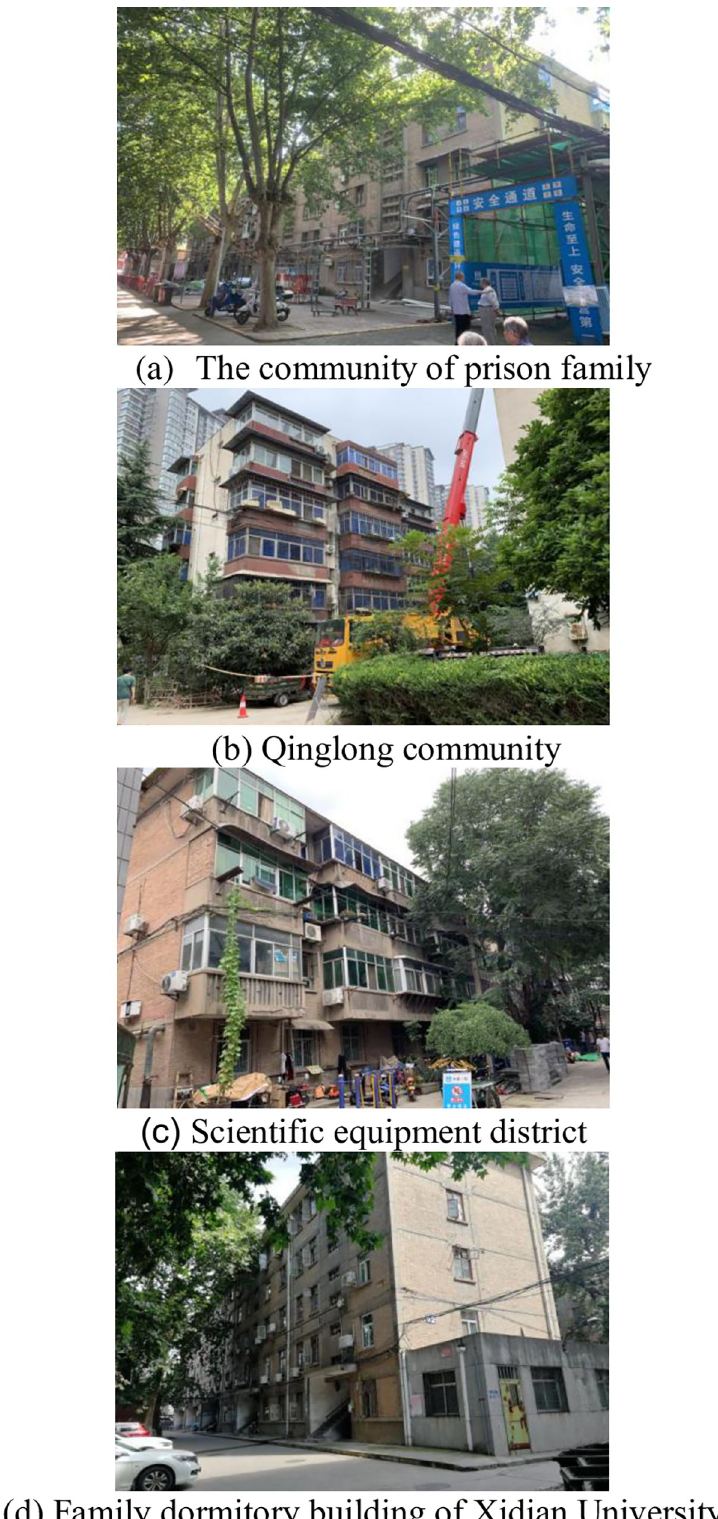
Fig 5. Investigate the status of communities. (a) The community of prison family. (b) Qinglong community. (c) Scientific equipment district. (d) Family dormitory building of Xidian University.